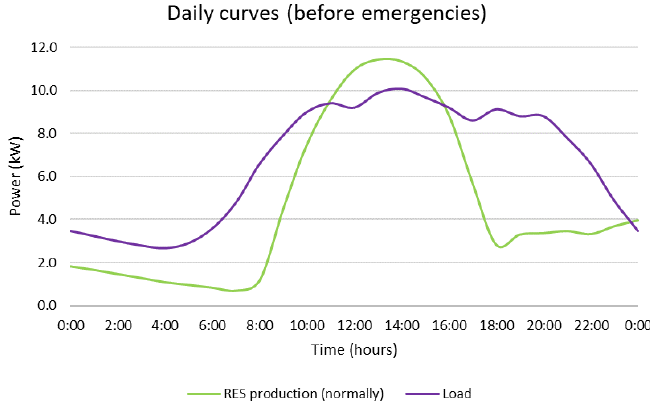
Figure 5. Profile of the simulated day without the emergencies. Figure 5 . Profile of the simulated day without the emergencies.